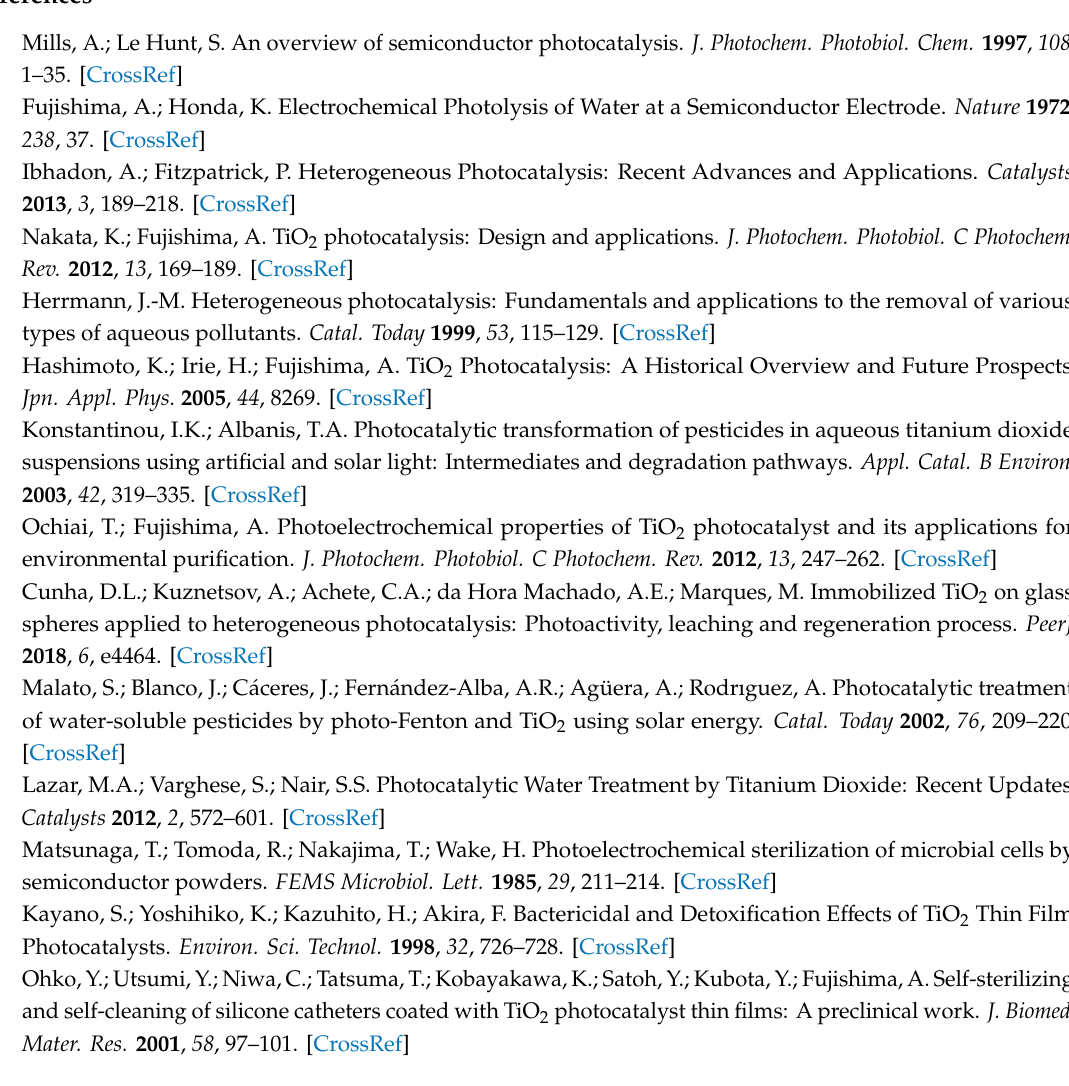
2 , Figure S18: TEM image of Co 3 O 4 , Figure S19: SEM image of Cu 2 O, Figure S20: TEM image of SrTiO 3 , Figure S21: SEM image of TiO 2 -CNTs, Figure S22: TEM image of TiO 2 -ZnO, Figure S23: TEM image of ZnFe 2 O 4 , Figure S24: TEM image of ZrO 2